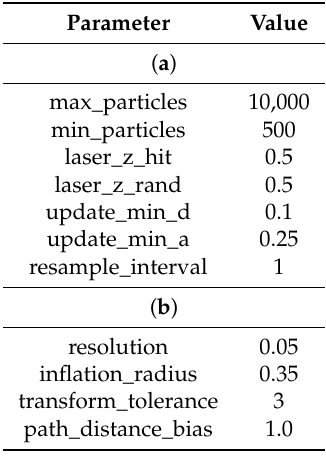
Table 1. The parameters used for the AMCL and mobe_base ROS packages. ( a ) Parameters used for AMCL ROS node; ( b ) parameters used for move_base